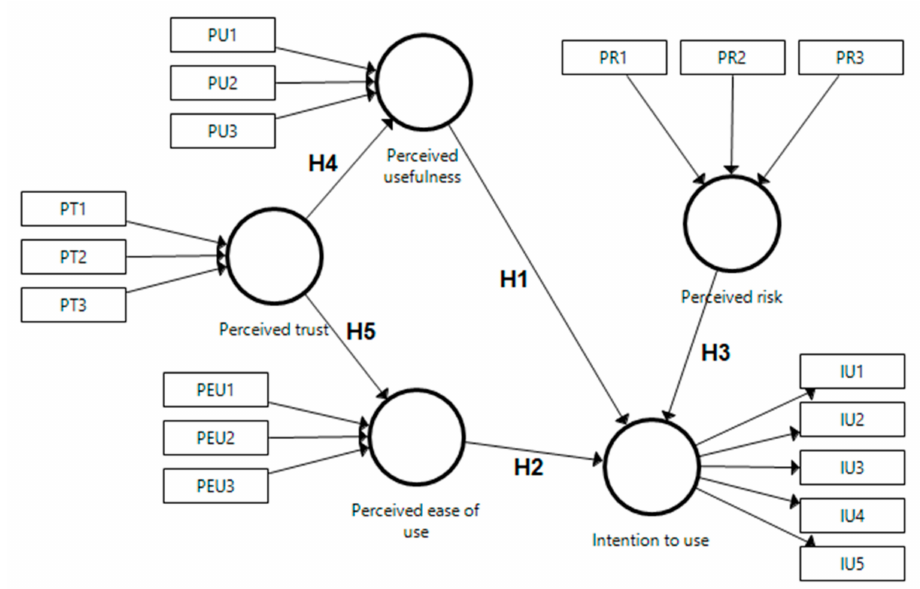
Figure 1. Model showing the impact of customer behaviour on e-currency purchases.